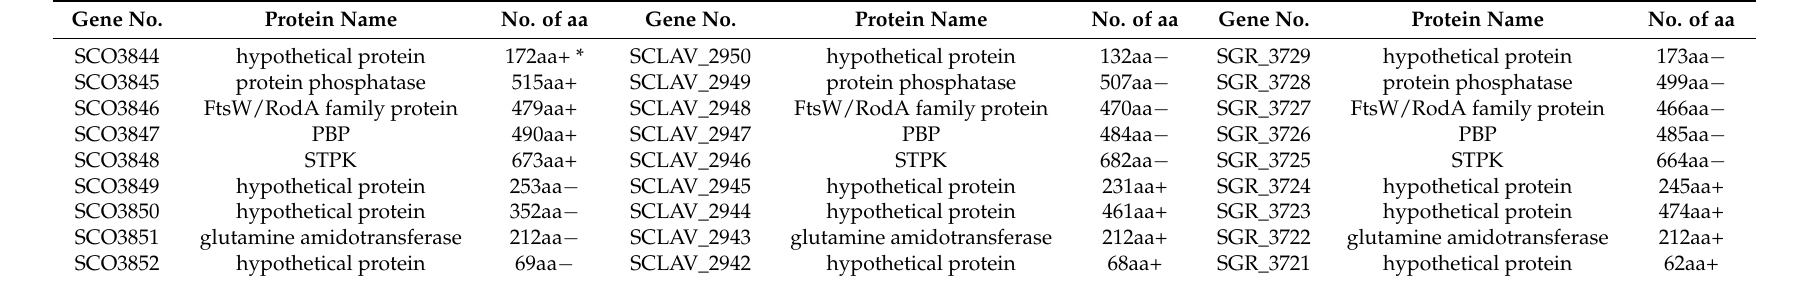
Table 7. Comparison of genomic structures in PBP-STPK region of three Streptomyces species. Gene